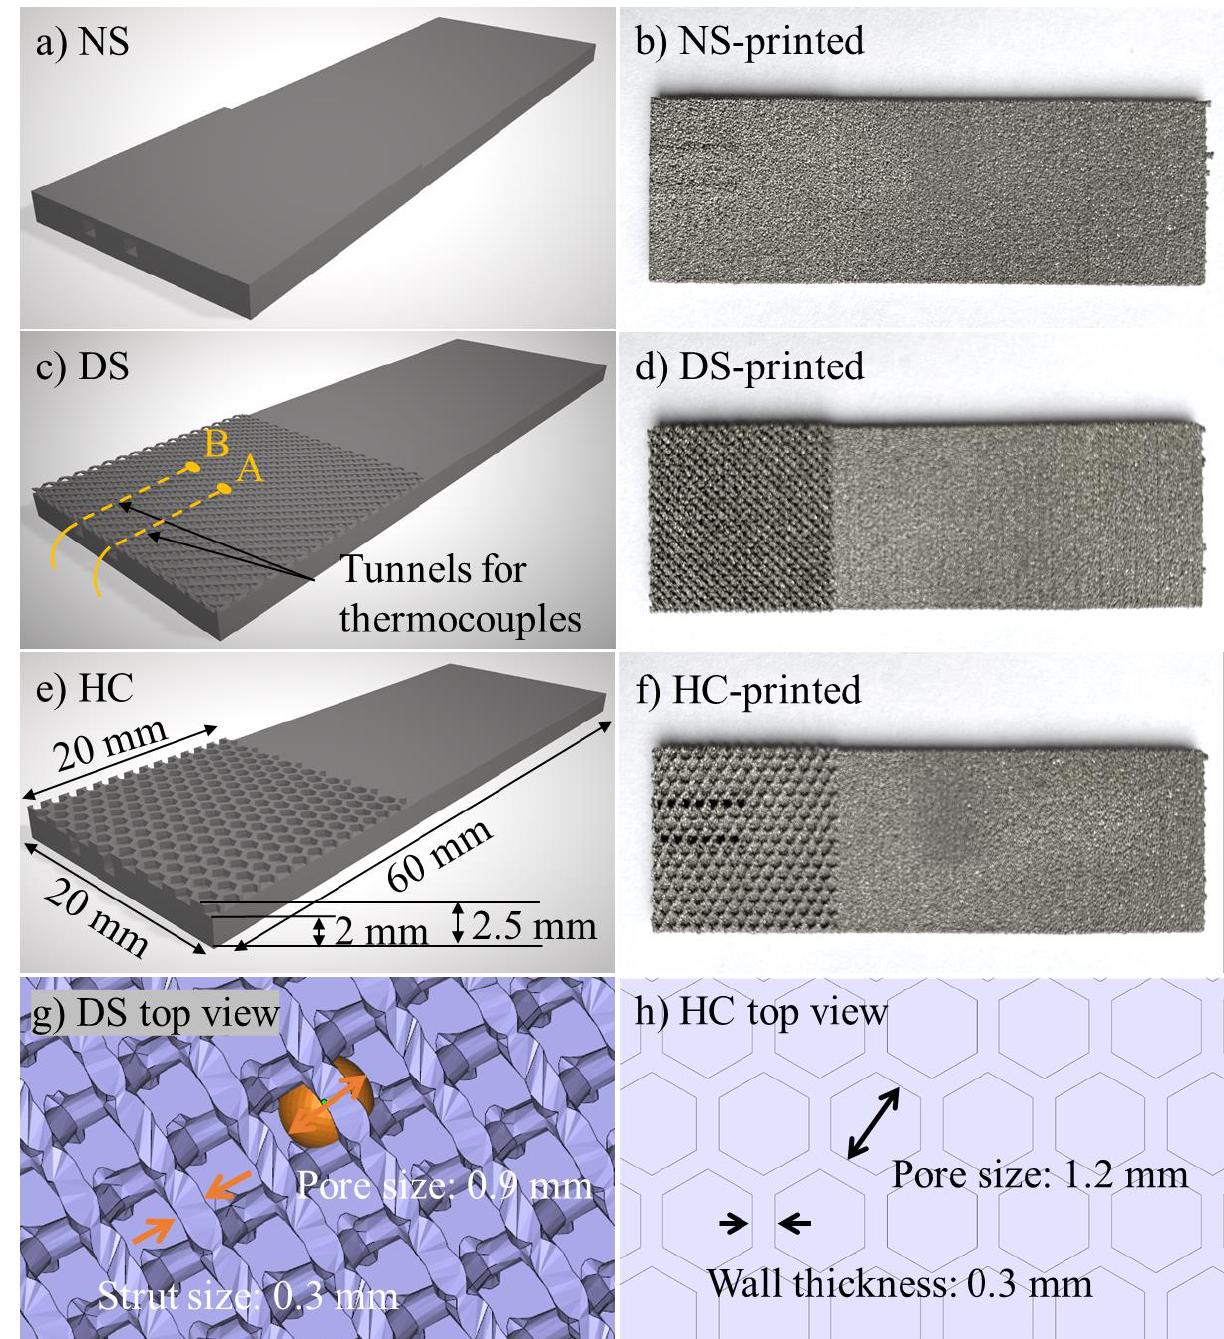
Figure 1. TC4 plates with different surface structures: ( a , b ) model and printed plate of non-structured (NS); ( c , d ) model and printed plate of diamond-shaped (DS) porous architecture; ( e , f ) model and printed plate of honeycomb (HC) architecture; ( g ) top view of DS; ( h ) top view of HC.